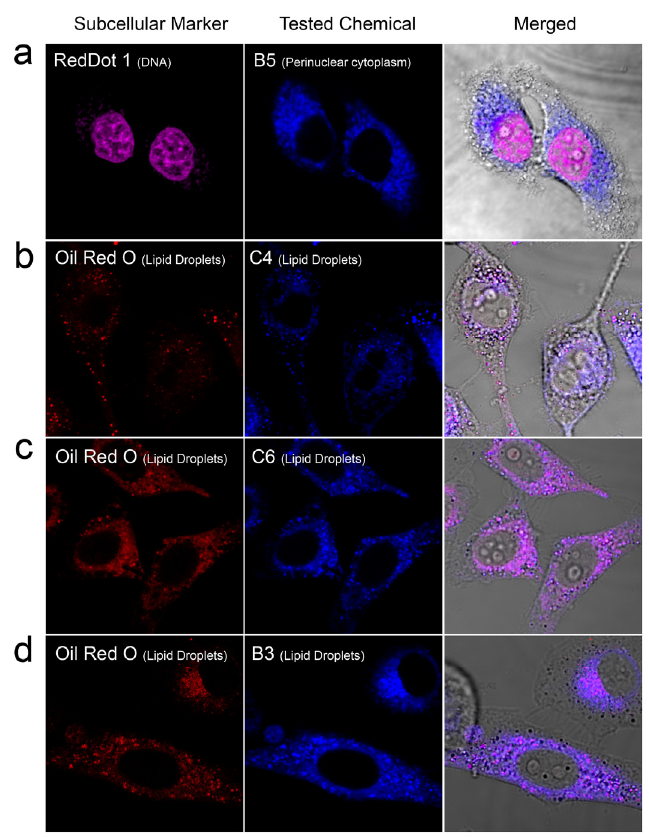
Figure 3. Colocalization of chemicals with fluorescent markers. Localization of the chemicals and the fluorescent markers are indicated on Figures. ( b – f ) Formaldehyde fixed cells were used for colocalization with Oil Red O. Live cell colocalizations were shown in ( a and g – l ). ( l ) Laser excitation-induced relocalization of chemical C2 to nucleolus/cytoplasm. NAO: Nonyl acridine orange; FDA: Fluorescein diacetate; H33342: Hoechst 33342; C2*: Photoconverted form of chemical C2. Arrows indicate two nucleoli. Scale bar 10